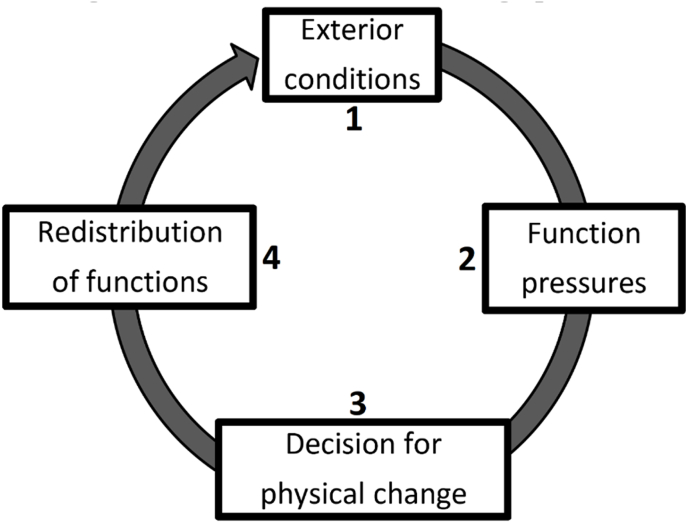
LUISA modelling framework for simulation of land-use change following pressures for the provision of land-based functions (adapted from Jacobs-Crisioni et al., 2017).